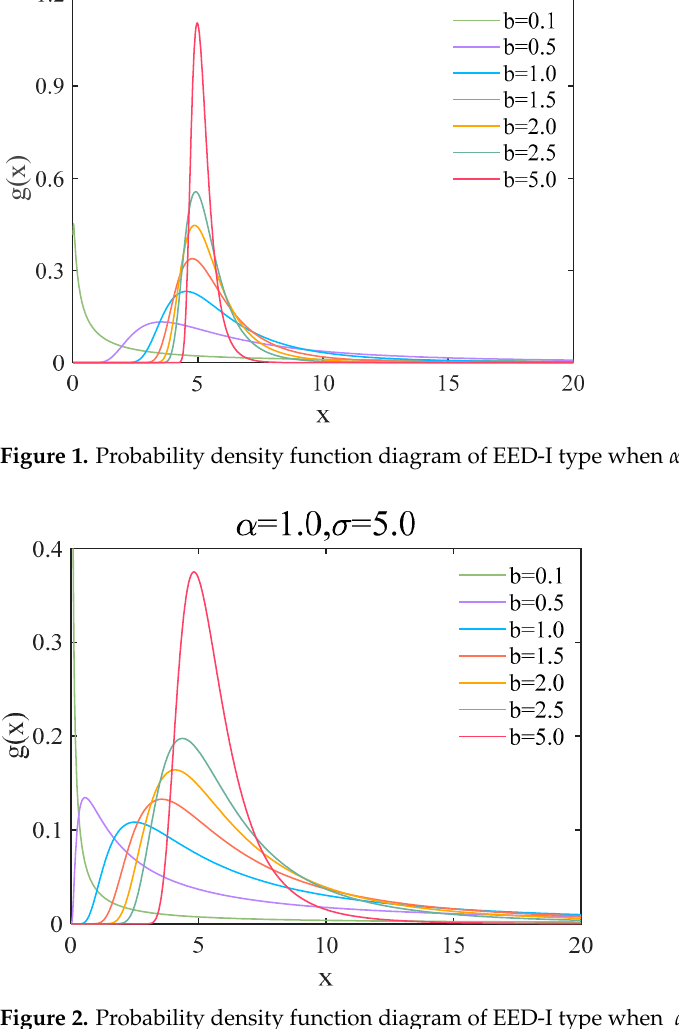
Figure 2. Probability density function diagram of EED-I type when 𝛼 = 1.0,𝜎 = 5.0 .